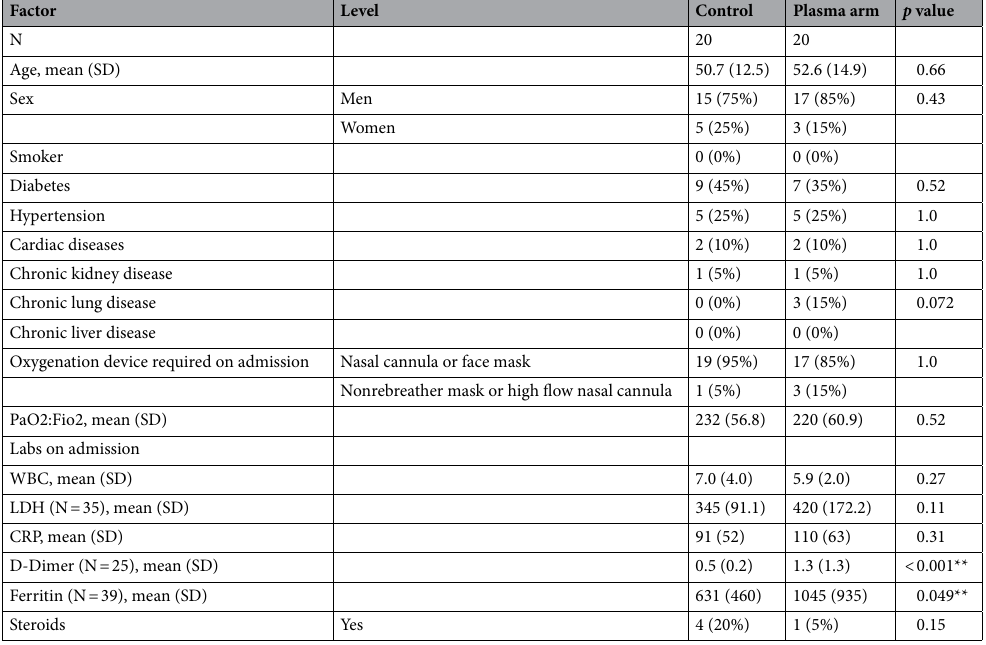
Table 1. Subject demographics, clinical and laboratory characteristics at baseline. **Wilcoxon Mann–Whitney